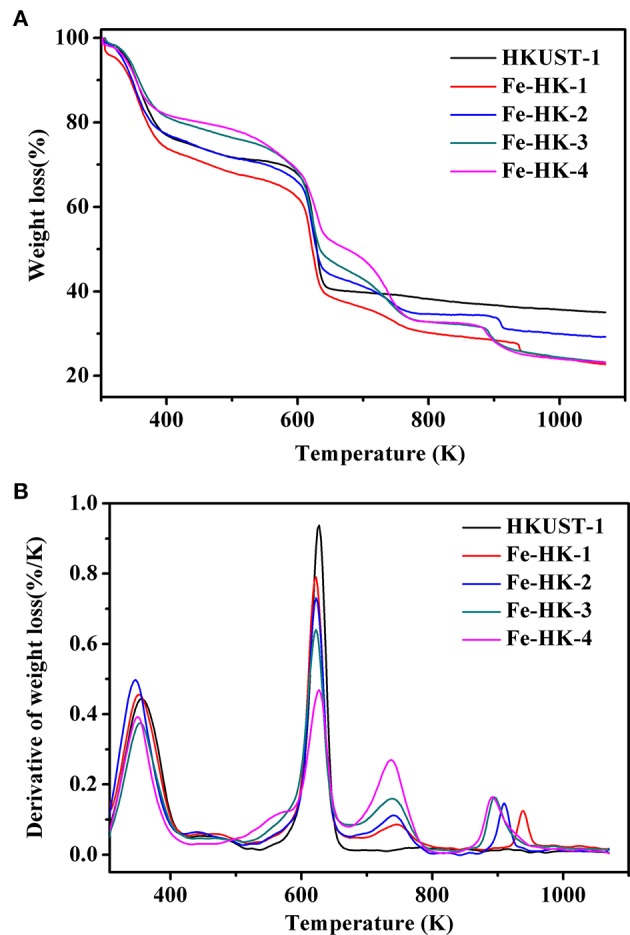
TG (A) and DTG (B) curves of HKUST-1 and Fe-HK samples.